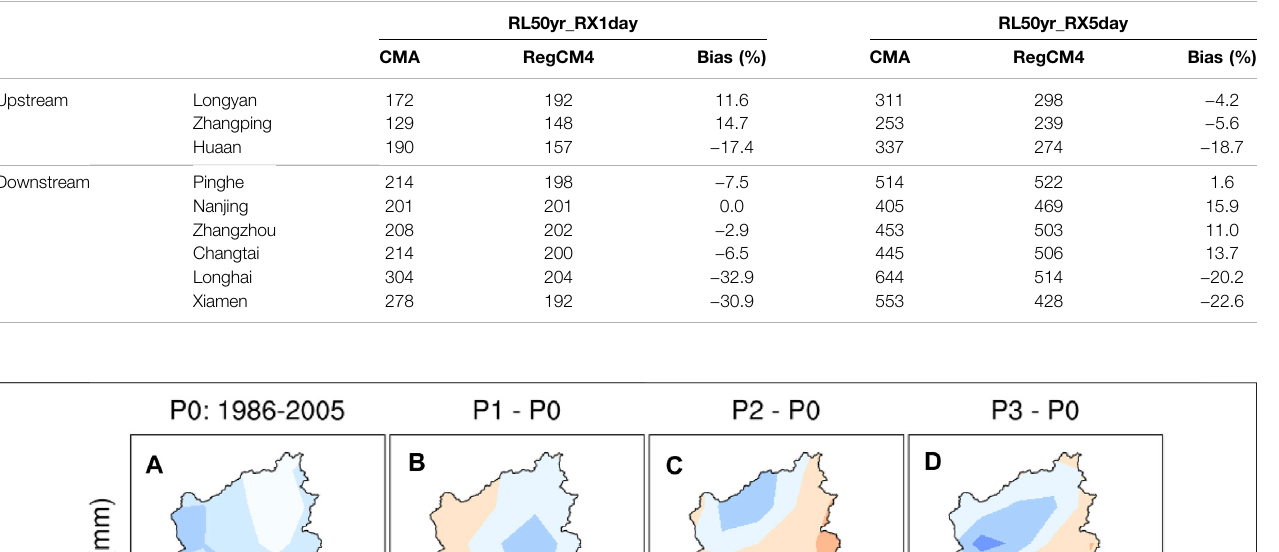
TABLE 2 | 50-year return levels (mm) of RX1day and RX5day estimated from RegCM4 outputs driven by HadGEM2-ES and observed station data (CMA), and their relative bias at Zhangping, Longyan, Huaan, Changtai, Nanjing, Pinghe, Zhangzhou, Longhai, and Xiamen meteorological stations over JRB during the reference period of 1986 – 2005.